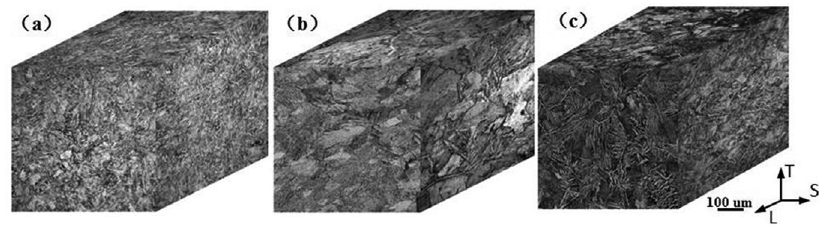
Figure 4: OM image of Ti-7Cu alloy with different forging temperatures: (a)1,000°C, (b)1,050°C and (c)1,100°C.